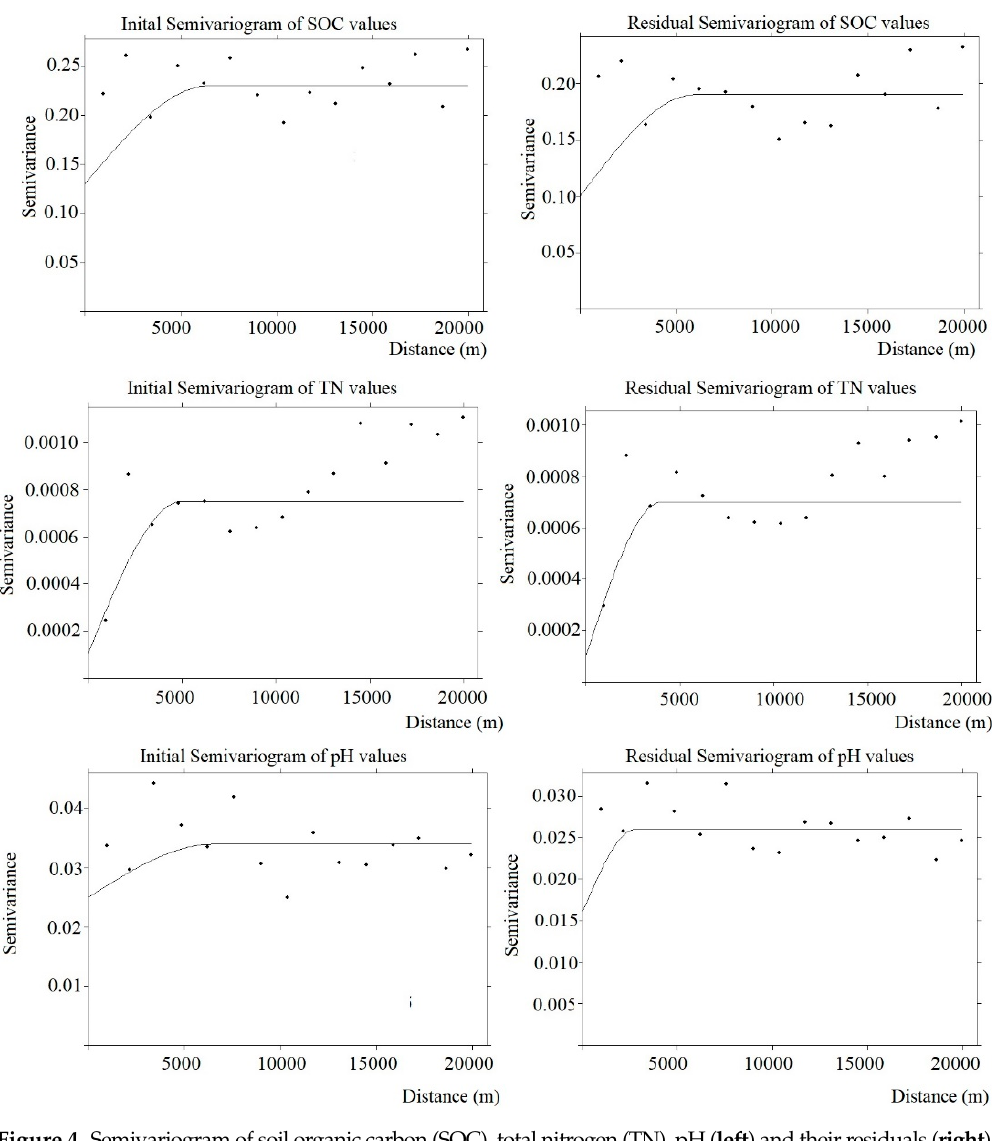
Figure 4. Semivariogram of soil organic carbon (SOC), total nitrogen (TN), pH ( left ) and their residuals ( right ). Table 3. Semivariogram parameters.